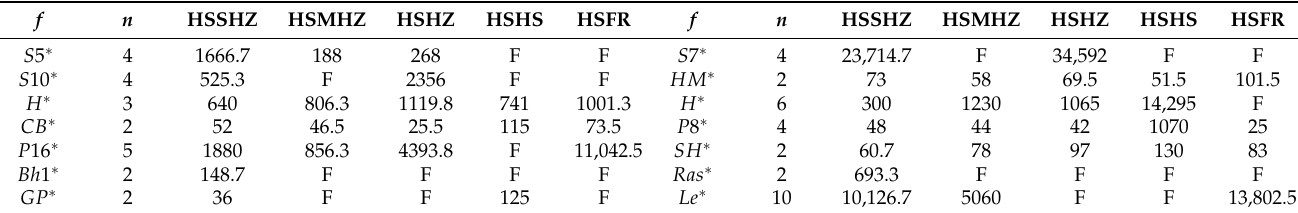
Table 15. The average of number of function